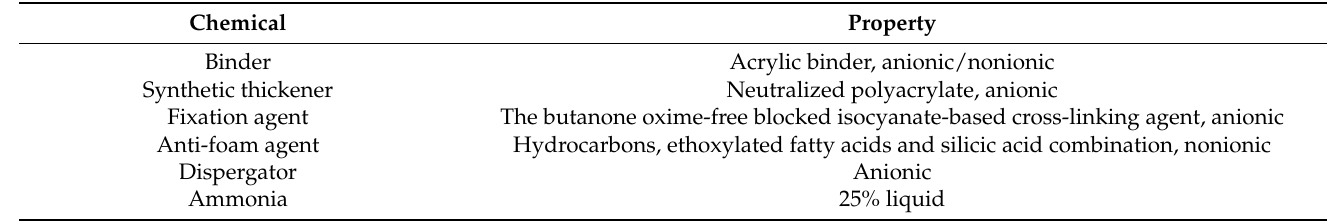
Table 2. Properties of coating chemicals.